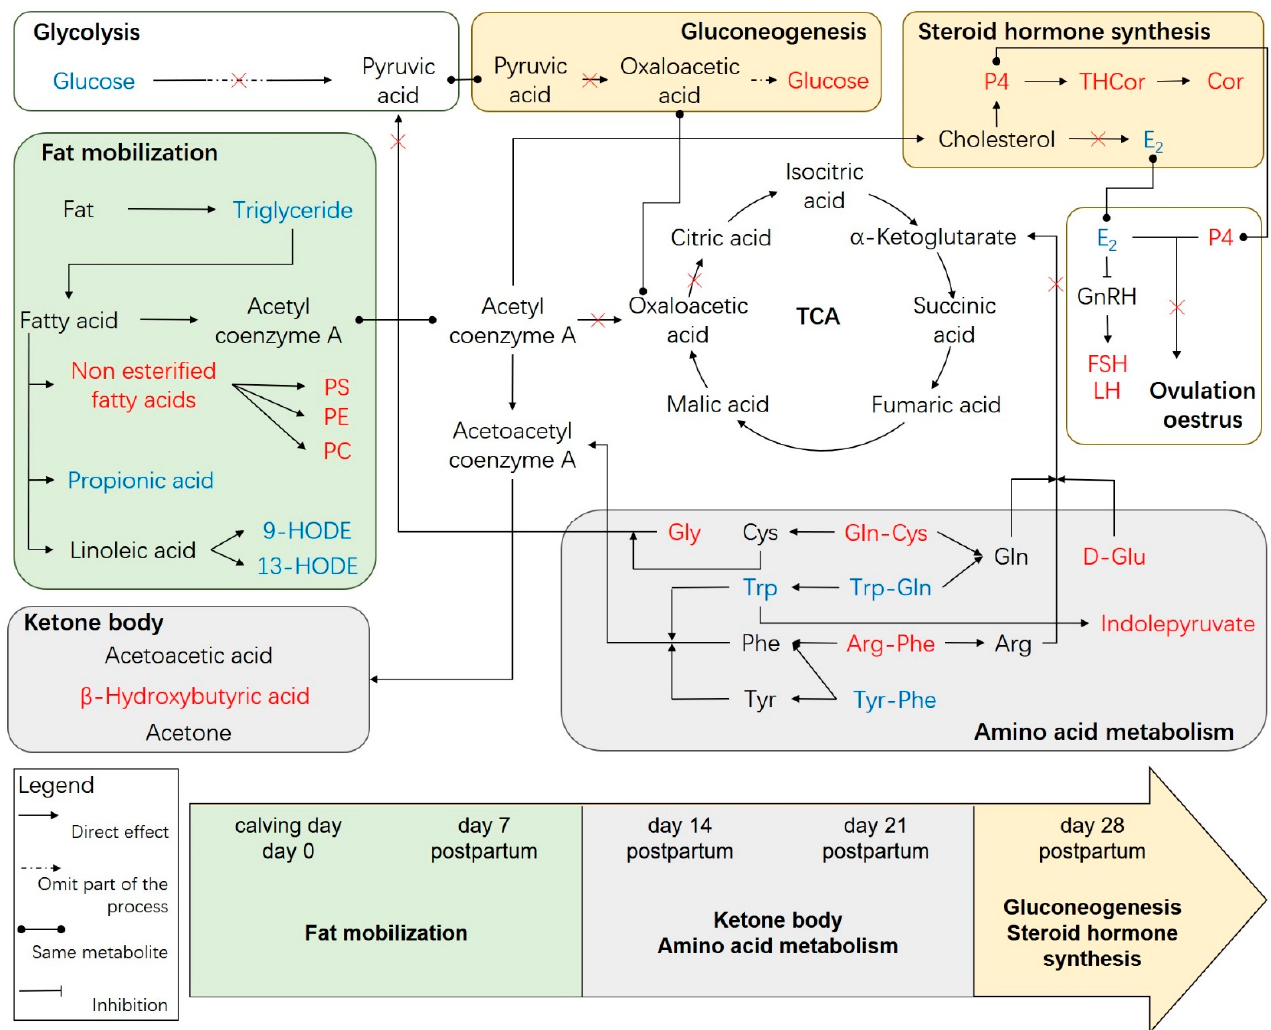
Figure 7. The metabolite network of female yaks during LPP. PS: a glycerol phospholipid metabo ‐ lite of free fatty acids; PE: a glycerol phospholipid metabolite of free fatty acids; PC: a glycerol phospholipid metabolite of free fatty acids; 9 ‐ HODE: 9S ‐ hydroxyoctadecadienoic acid;13 ‐ HODE: 13S ‐ hydroxyoctadecadienoic acid; Gly: glycylleucine; Cys: cysteine; Gln: glutamine; D ‐ Glu: D ‐ glutamic acid; Trp: tryptophan; Phe: phenylalanine; Arg: arginine; Tyr: tryptophan; THCor: tetra ‐ hydrocortisol; Cor: beta ‐ cortol; GnRH: gonadotropin ‐ releasing hormone; E 2 : estradiol; P4: proges ‐ terone; FSH: follicle stimulating hormone; LH: luteinizing hormone; and TCA: tricarboxylic acid cycle. The metabolic process of the same background color indicates that it functions at the same time. The metabolites marked with red indicate that the expression is up regulated at the stage, while blue indicates that the expression is down regulated. “ ” direct effect; “ ” omit part of the process; “ ” same metabolite; and “ ──│ ” inhibition; “×” bloked.